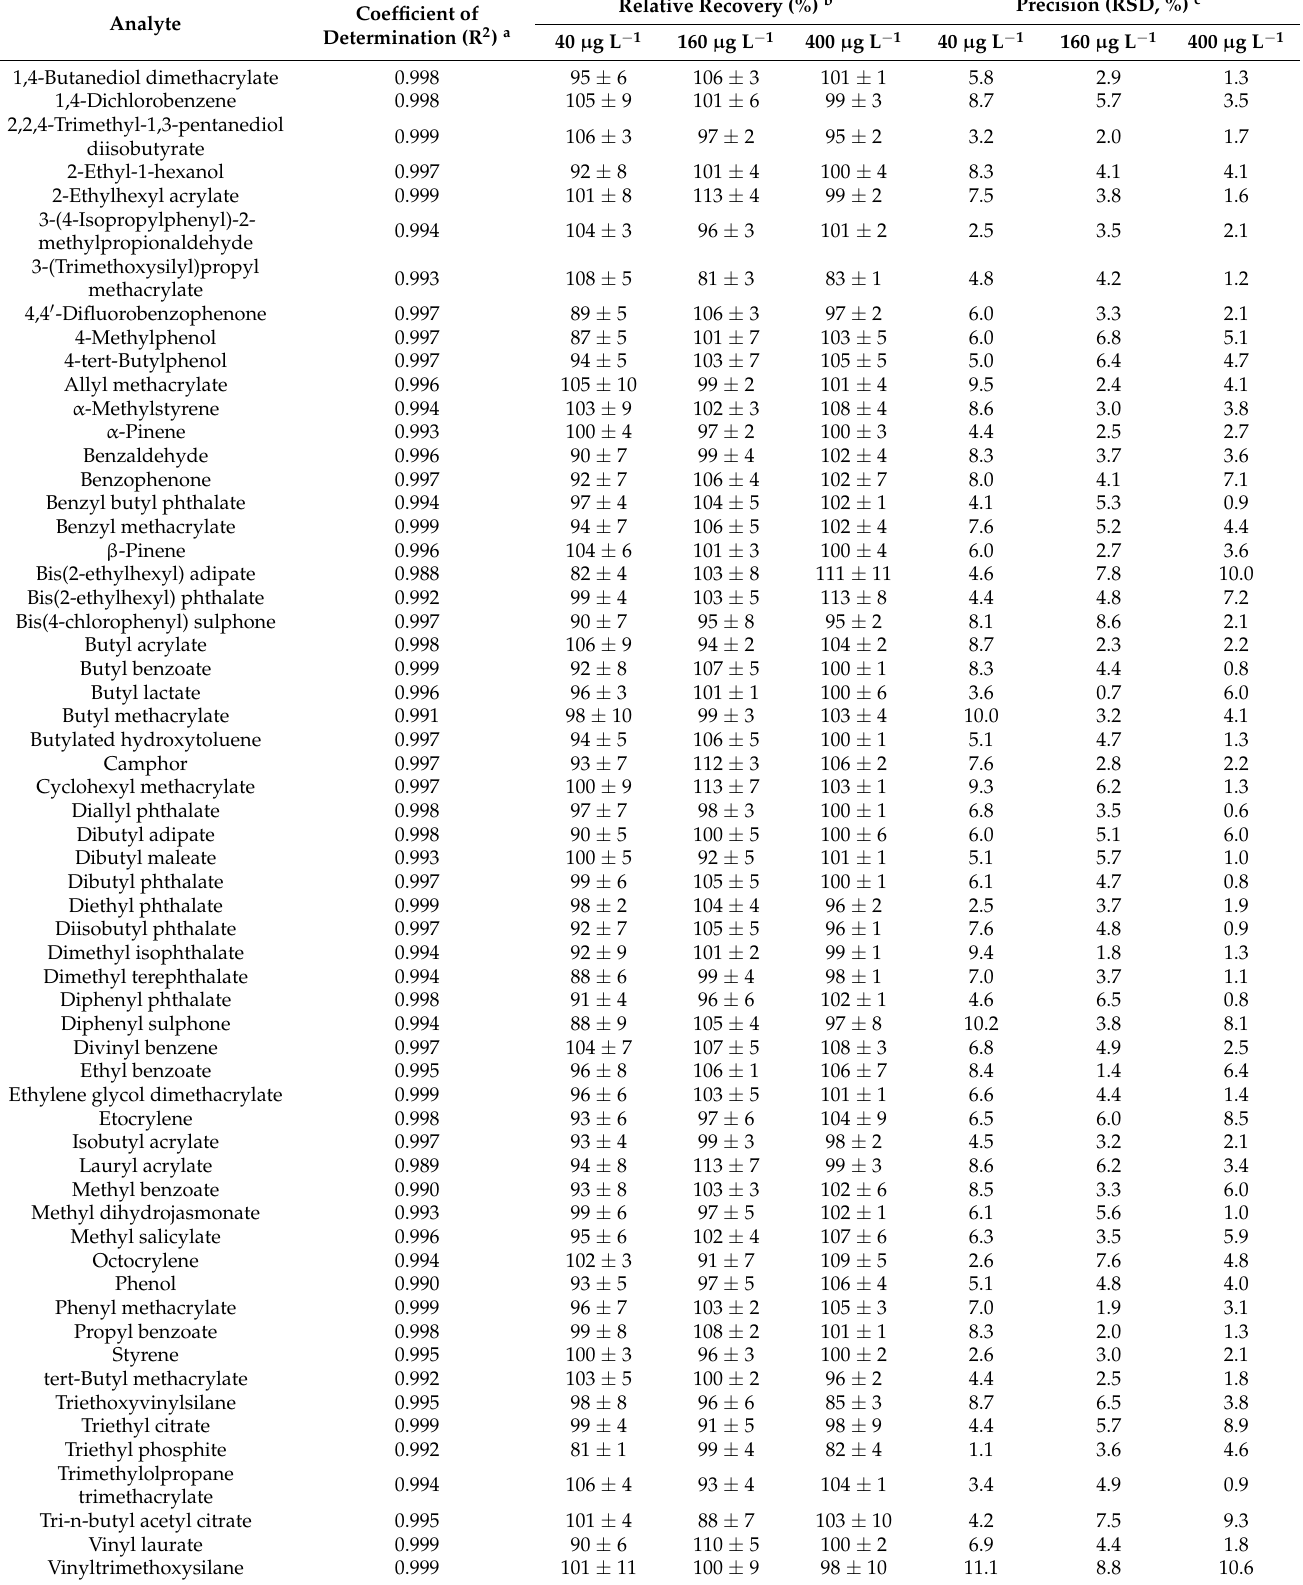
Table 2. Analytical figures of merit of the proposed method using food simulant